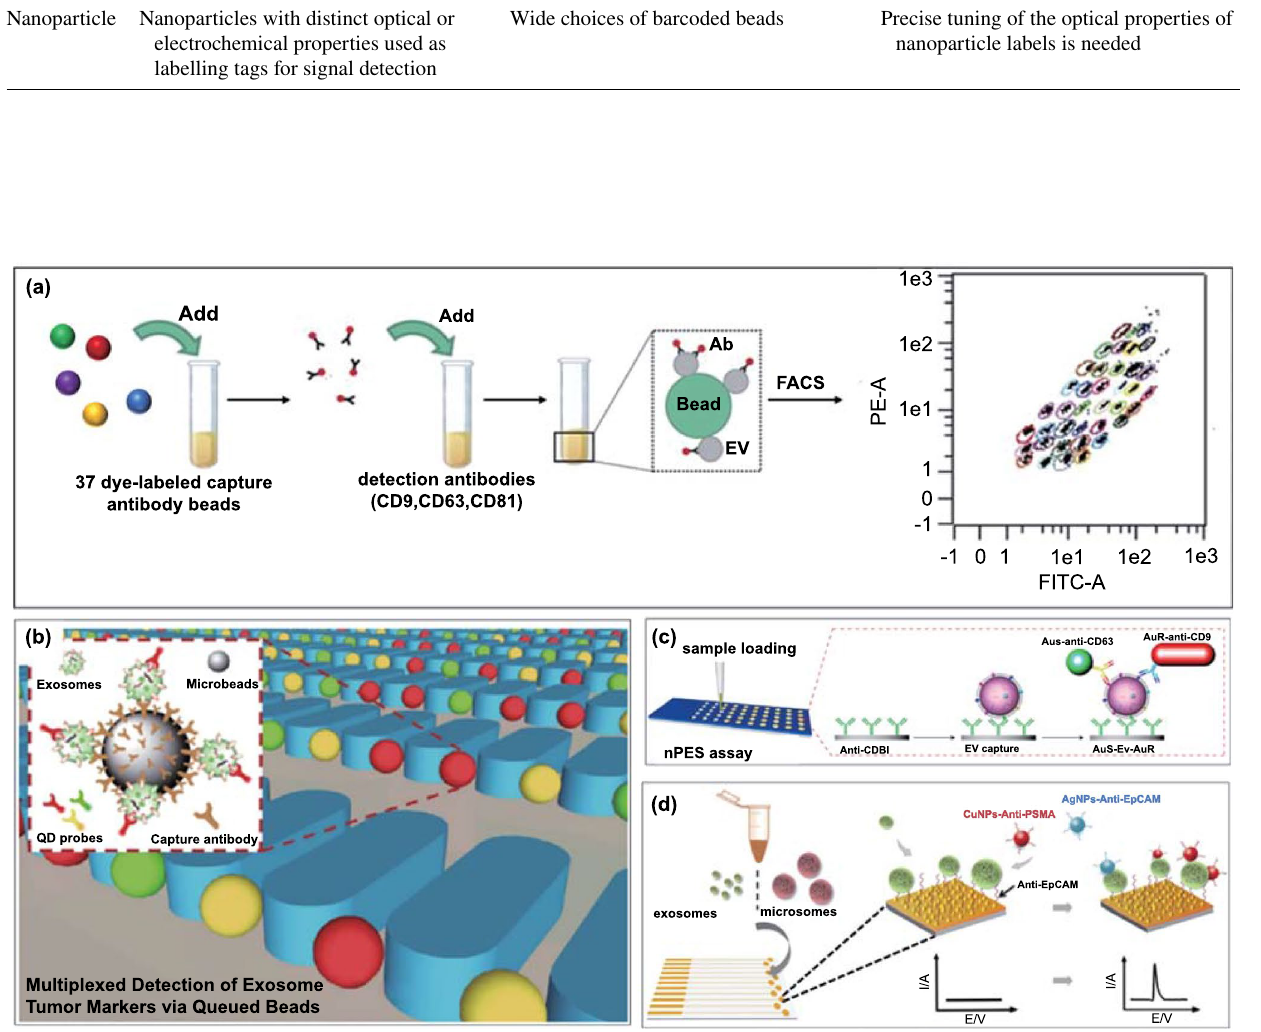
Fig. 10 Nanoparticle coding strategy for EV multiplexing using a fluorophore doped beads. Reproduced with permission from Ref. [165]. Cop- yright 2020 AAN Publications. b Quantum dots. Reproduced with permission from Ref. [185]. Copyright 2019 Springer. c Plasmonic nanoparti- cles. Reproduced with permission from Ref. [177]. Copyright 2017 Springer Nature. d Redox active Cu and Ag nanoparticles. Reproduced with permission [179]. Copyright 2014 John Wiley &